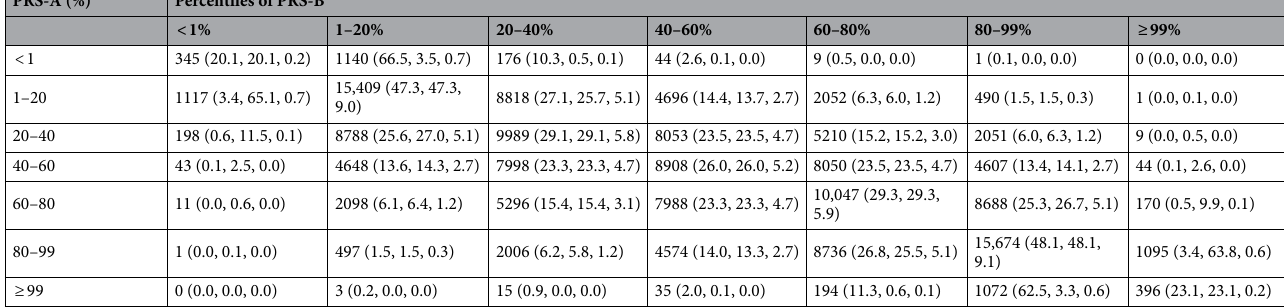
Table 3. Cross-classification of predicted risk of breast cancer among the whole study population, according to the percentiles of each PRS. Number of participants are shown as n (col%, row%, cell%). Higher percentiles of PRS indicate increased risk of breast cancer; “≥ 99%” percentile corresponds to the top 1%